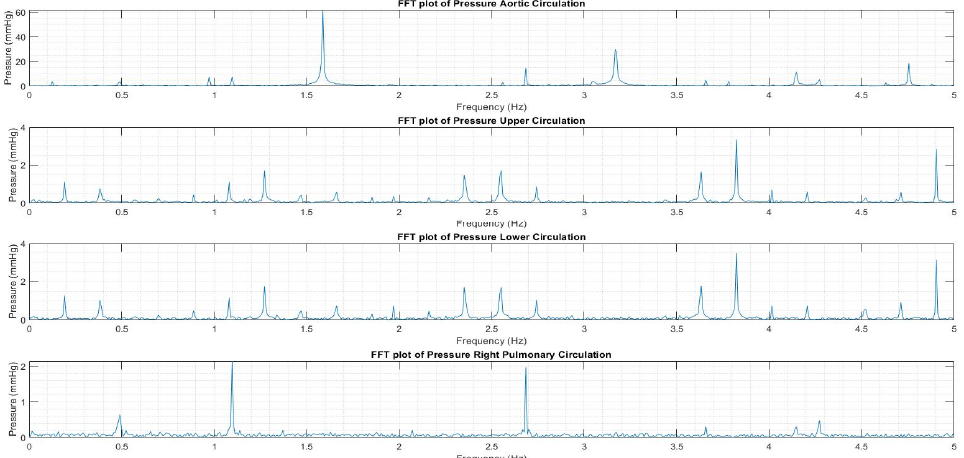
Figure A4. FFT on flow waveform for 3 mm IJS with 30% PVR.